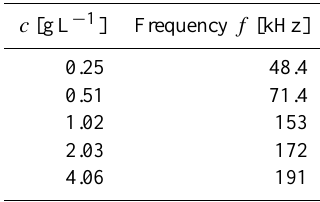
the concentration of the suds ( r ≈ 1) as long as they do not